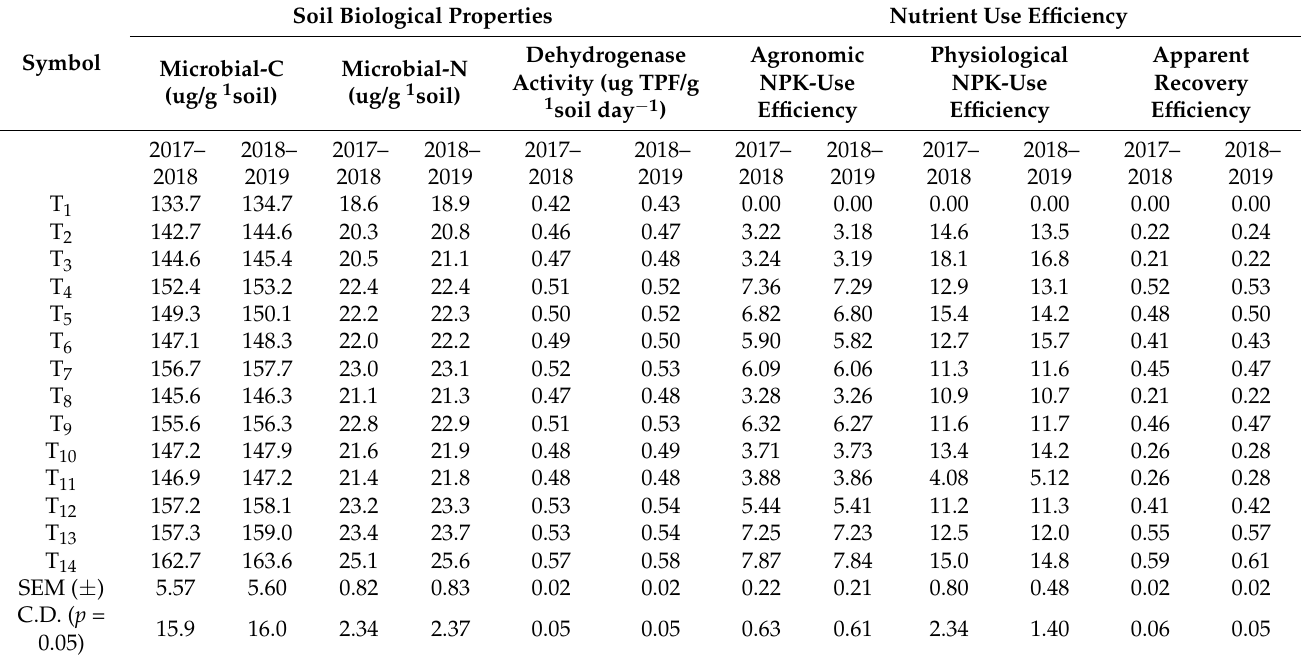
Table 6. Nutrient management strategies effects on microbial C, microbial N and dehydrogenase activity of soil and nutrient use